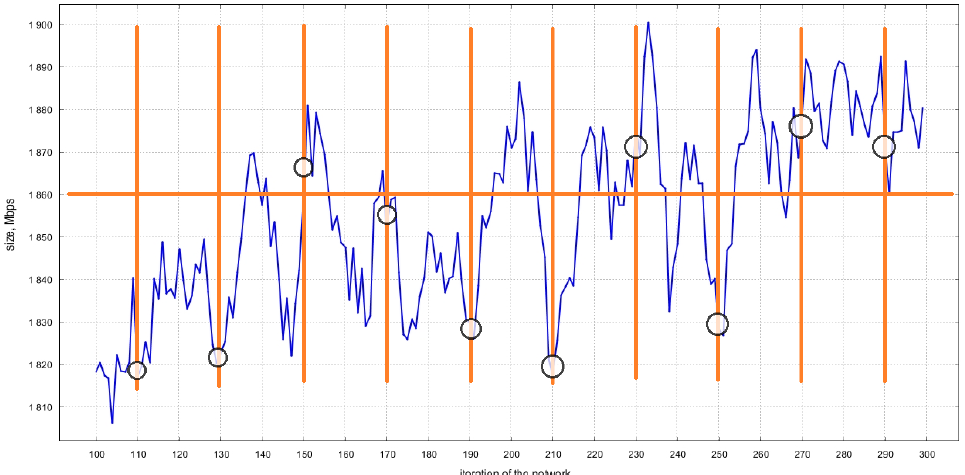
Figure 33. Decision points to change the network configuration.